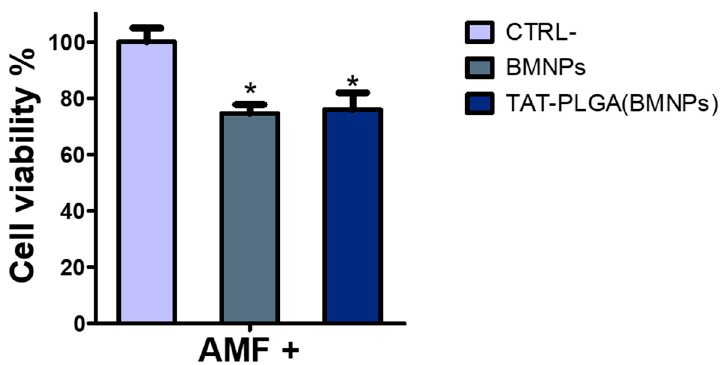
Figure 6. Cytotoxicity on U87MG of the nanoassembly combined with the application of an alter- nating magnetic field (AMF). U87MG cells were treated with BMNPs and TAT-PLGA(BMNPs) and exposed to an alternating magnetic field for 2 h. Statistical differences between the treatments were considered significant when p values were p ≤ 0.05